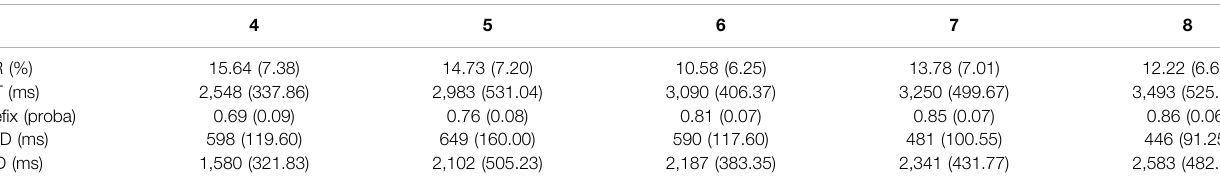
TABLE 2 | Average lexical decision response times and error rates, and averages of the three eye-tracking measures for each length (in number ofletters) for pseudowords.